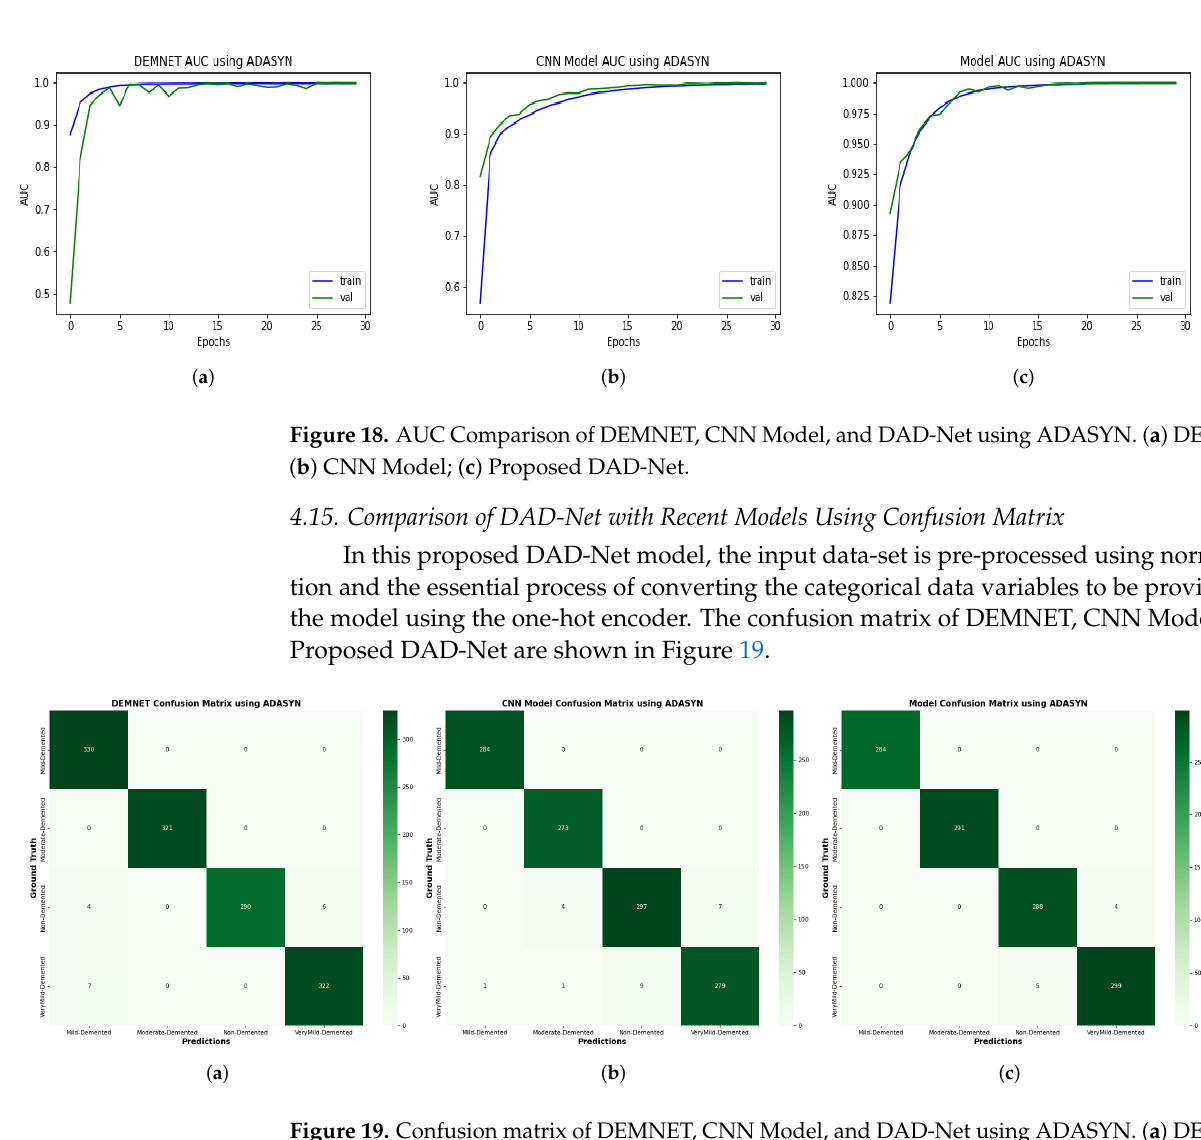
Figure 19. Confusion matrix of DEMNET, CNN Model, and DAD-Net using ADASYN. ( a ) DEMNET; ( b ) CNN Model; ( c ) Proposed